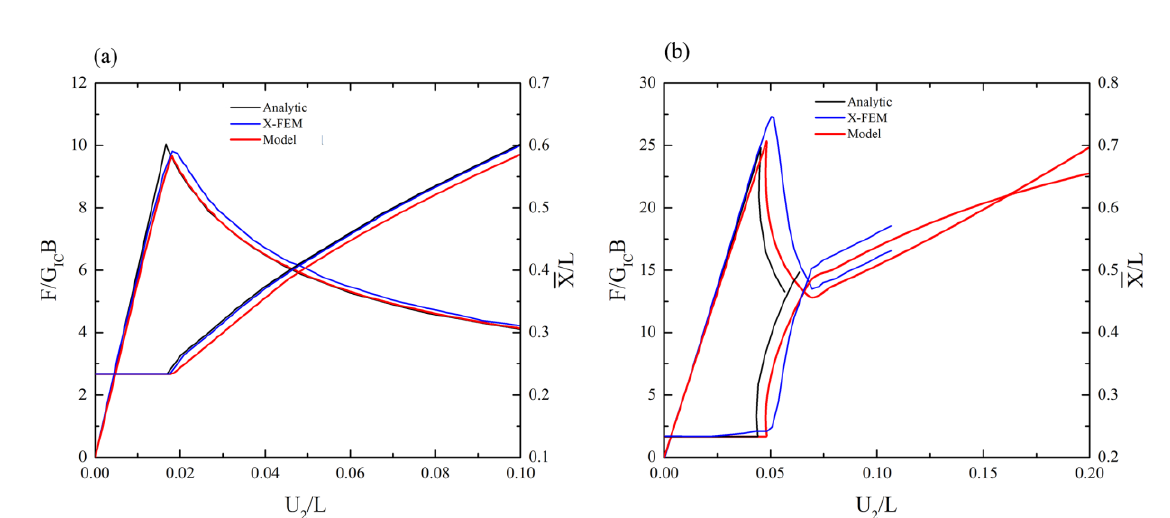
Fig. 4 . Comparison results: Loading curve and crack tip position for DCB test (a) and MMB test